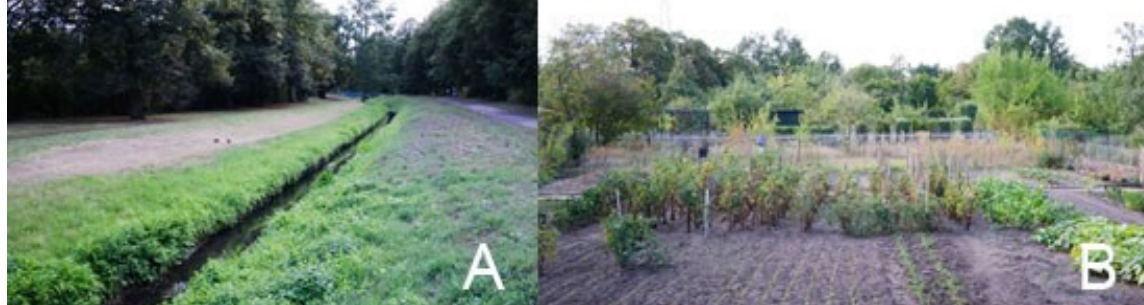
Figure 3. Fragment of section plan of Wroc ł aw (at that time Ger. Breslau) from the 1930, with